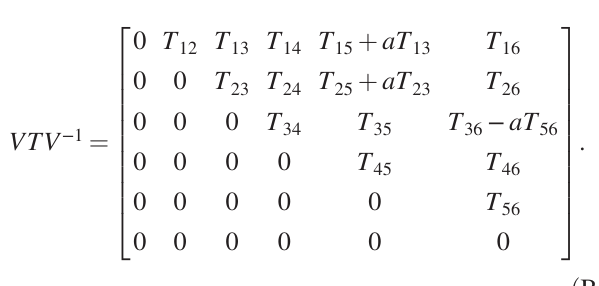
FIG. 15. The form of T matrix (left) and J